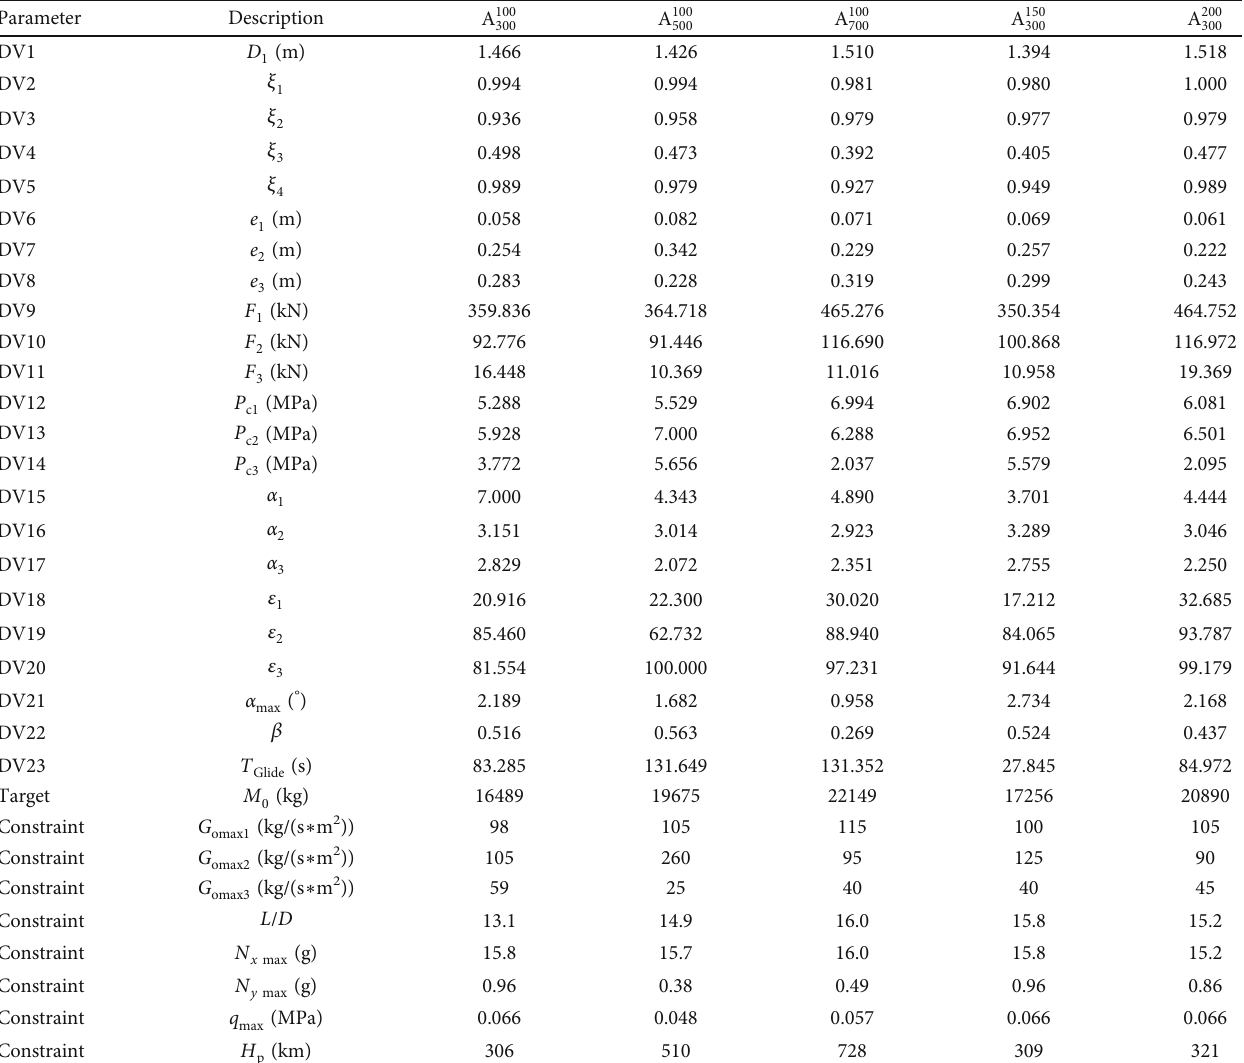
Table 10: Optimal results of SLV cases with di ff erent payload mass/orbit heights.